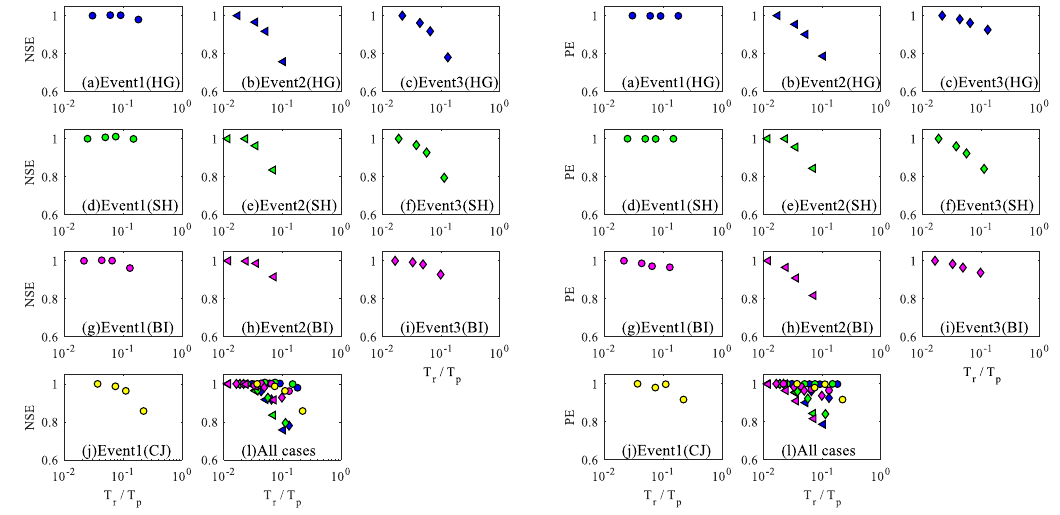
Figure 8. NSE and PE values for runoff predictions with various RTRs with 𝐿 𝑟 = 250 m .